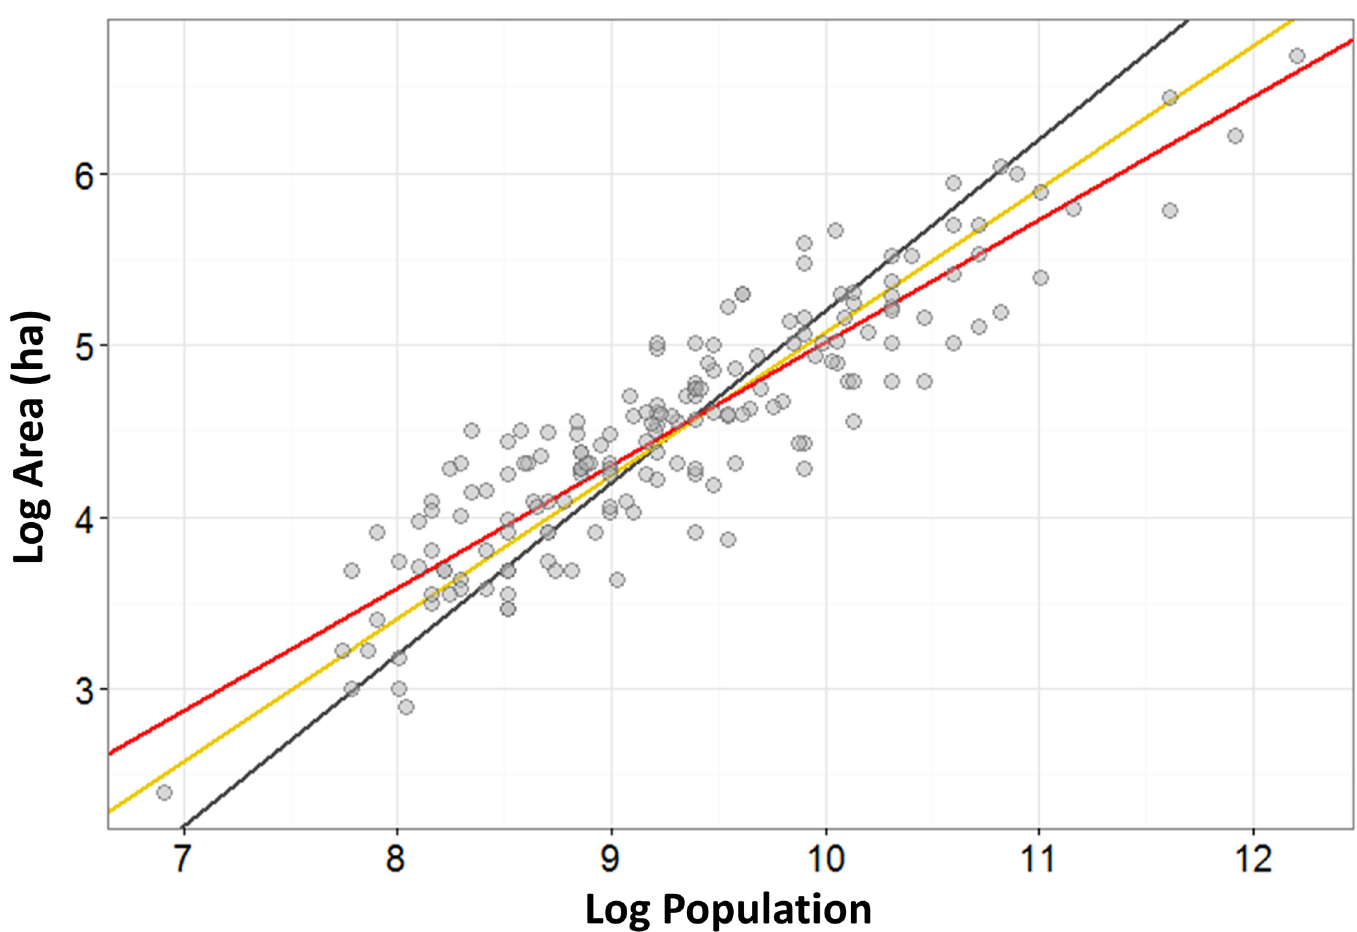
Fig 4. Estimation of Area — Population Scaling Relation for All Settlements. The Area — Population scaling relation for the entire data set of all medieval cities ( n = 173 ). The black line represents proportionate (linear) scaling; the yellow line the theoretical prediction where α = 5/6; and the red line the best-fit line from OLS regression of the log-transformed data.